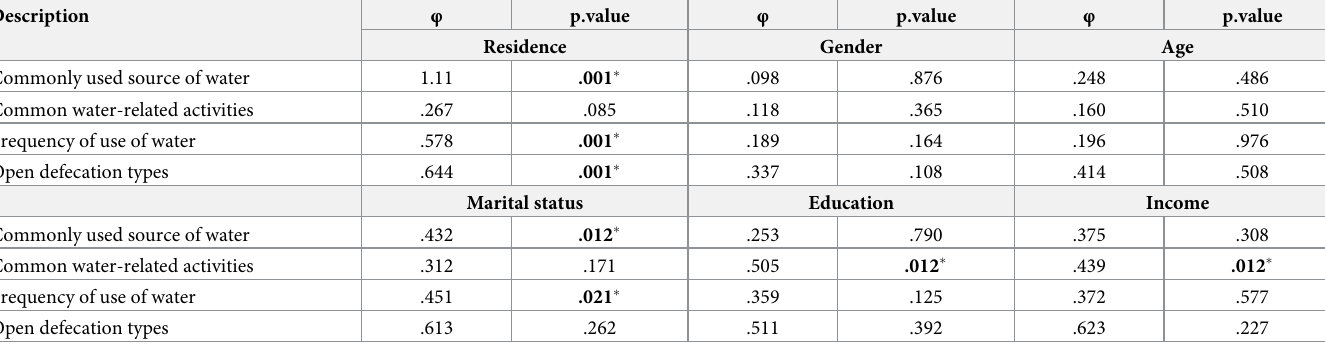
Table 7. Association between respondents’ socio-demographics and practices regarding